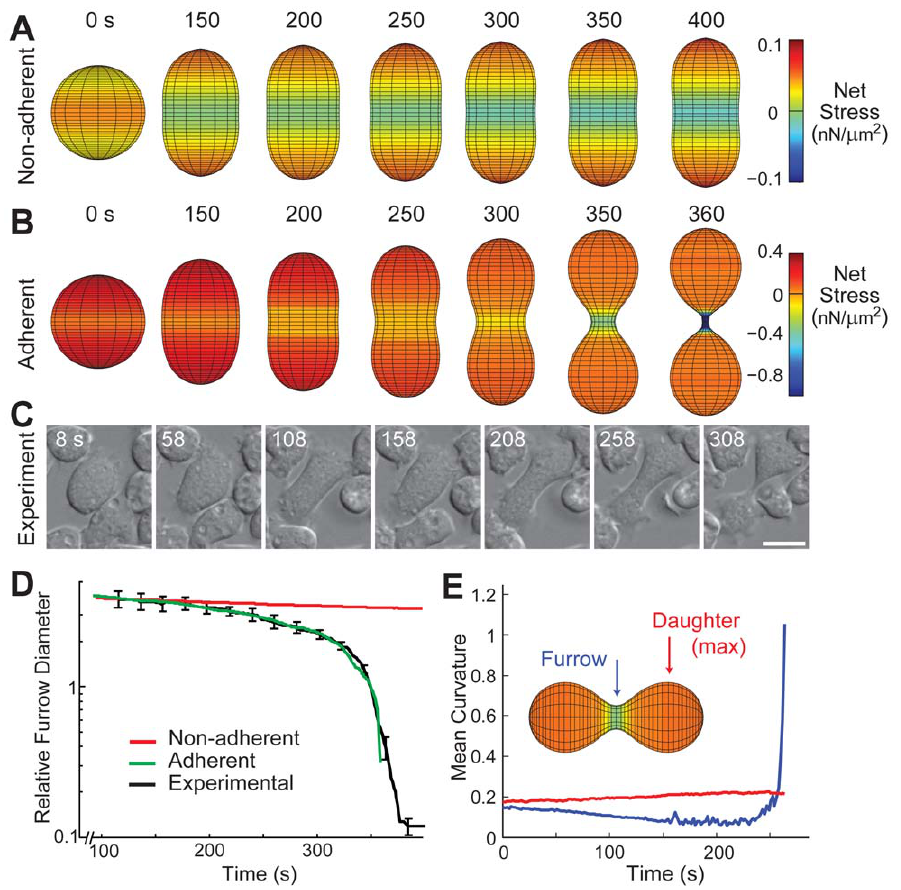
Figure 3. Simulation of myoII null cells. Morphological changes in a model where there is a spatial difference in cortical tension for both non- adherent (A)and adherent(B) cells (Video S2). Simulation timesare from theinitial spherical shape. Thedistribution of thestresses in theadherent caseis shown in Fig. S5. C. Experimental data are taken from myoII null cells dividing on a surface. Experimental times are from Video S3. Scale bar denotes 10 m m. D. Comparison of the furrow thinning trajectory. The experimental data represents mean 6 SEM and are taken from reference [12]. To compare the shapes at comparable times, time is rescaled so that the cross-over points coincided (Methods). E. Curvature in a simulation of adherent cells. The curvature at the furrow initially decreases slowly but reaches a minimumbefore increasing. This causes the stress to increase further increasing curvature and thereby closing a positive feedback loop which leads to rapid cell ingression. The curvature of the daughter cell changes relatively little.